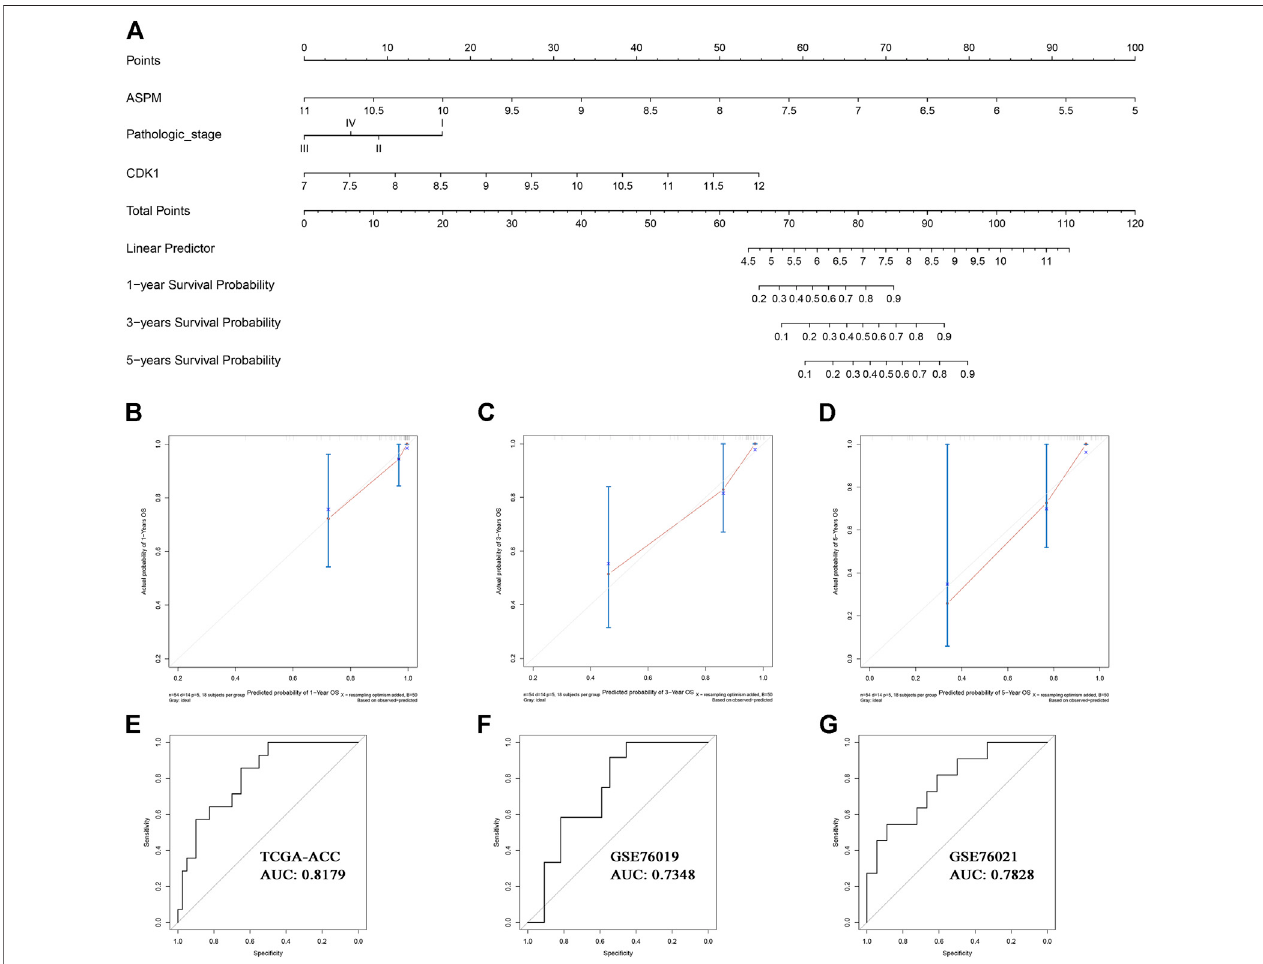
FIGURE8 | The nomogram for predicting the proportion of ACC patientswith 1-, 3-,or 5-years DFS (A) . The calibration plots forpredicting 1- (B) ,3- (C) , or 5- (D) year DFS.Receiver operating characteristic (ROC) curves and areaunderthe curve (AUC)statisticstoevaluate the diagnostic ef fi ciency ofthe nomogram inTCGA-ACC data (E) , GSE76019 (F) , and GSE76021 (G)